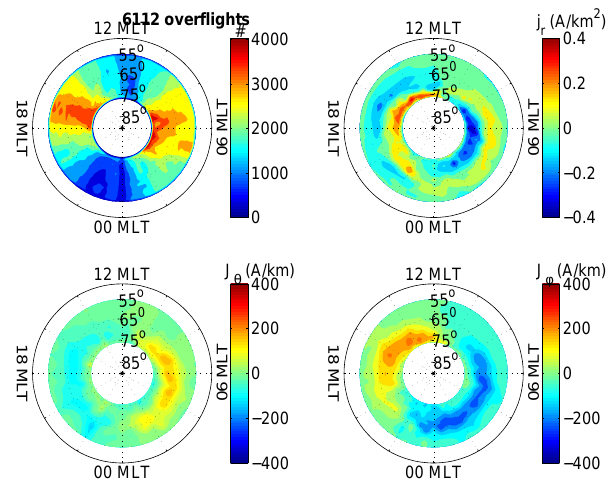
Fig. 10. Distribution of data points ( top, left ) for the 6112 1D overflights as a function of magnetic latitude and MLT. Here, one data point refers to one measurement in the 1 Hz CHAMP data, with the total number of points 2195327. j r ( top, right: field-aligned component, positive up), J θ ( bottom, left: north-south component, positive south) and J φ ( bottom, right: east-west component, positive east) as a function of MLT and magnetic latitude. The number of data points or the magnitude and direction of the current density in each cell is given according to the color bar on the right hand side of the plot. Resolution of the plots is 0 . 5 h in MLT and 1 ◦ in latitude. On the top of the figure is written the total number of overpasses used to construct the set of four plots.